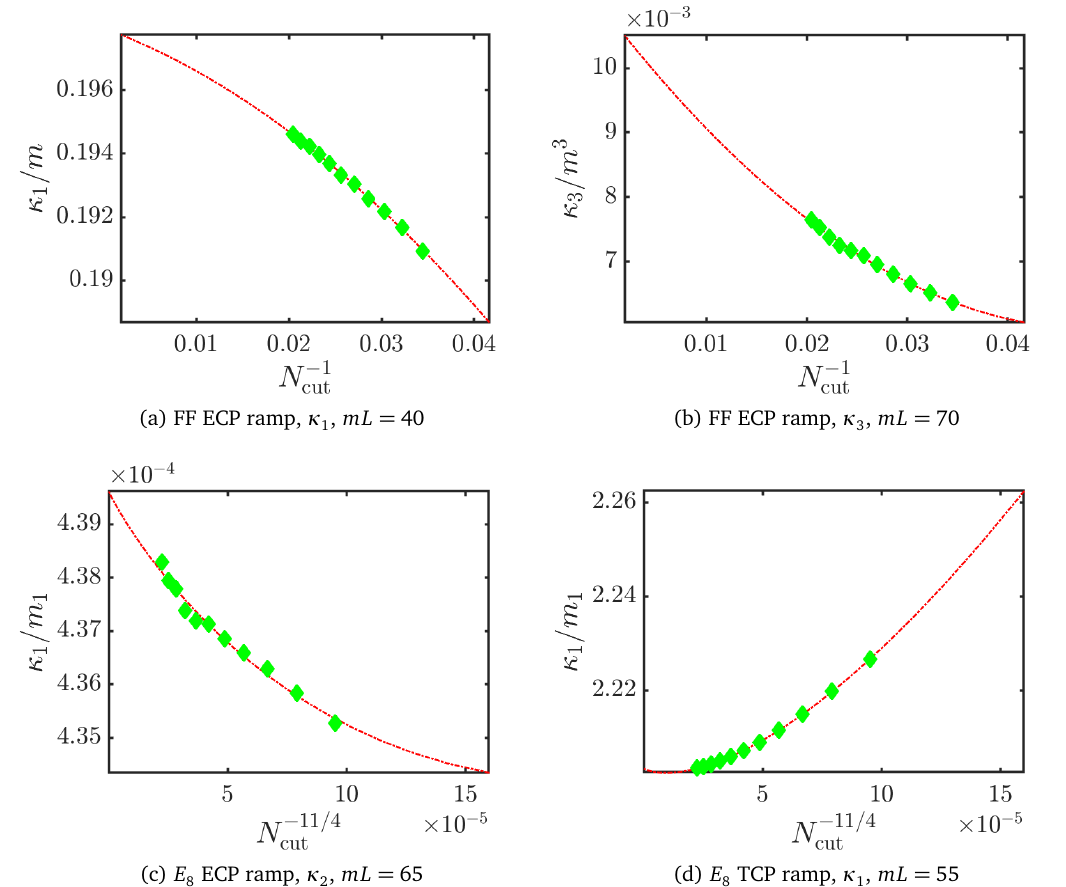
Figure C.3: Extrapolation of various work cumulants for various protocols. The plots are typical of the overall picture of extrapolating overlaps obtained using